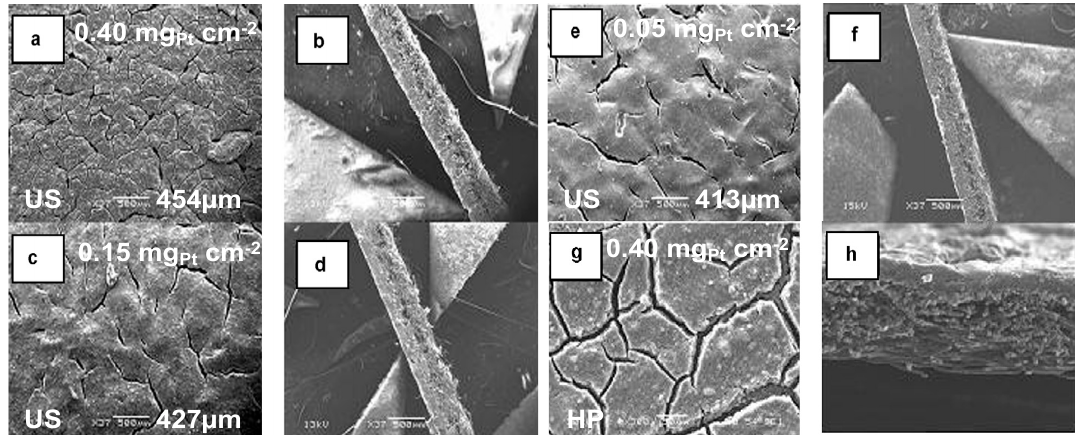
Figure 15. Polarization and power density curves comparing ultrasonic-sprayed and hand-painted SGL 10BC GDLs. Anode (A) = 50%; cathode (C) = 50%. The loadings for the MEAs were; ultrasonic sprayed: A = 0.05 mg cm − 2 , C = 0.15 mg cm − 2 and hand-painted: A = 0.09 mg cm − 2 , C = 0.18 mg cm − 2 [27].